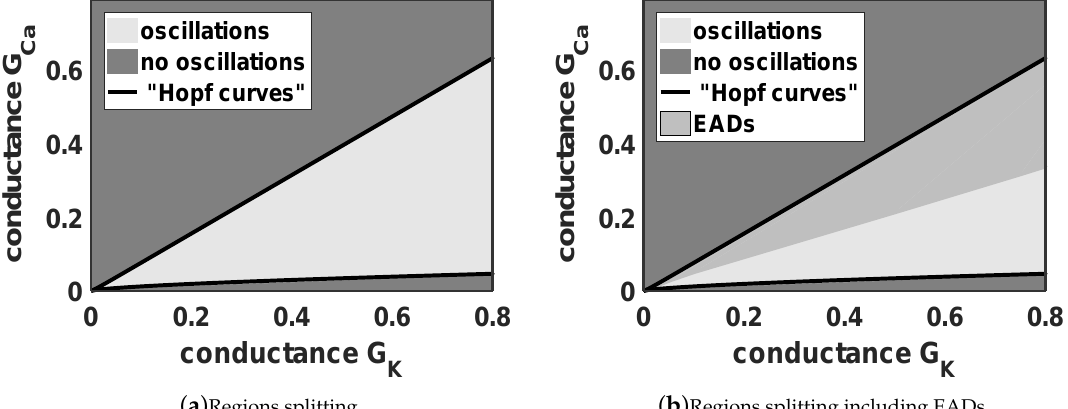
Figure 9. The two black lines represent the two “Hopf-curves”. Between these lines oscillations occur (light grey area), while outside this area (dark grey areas) no oscillations (in the sense we mentioned in Section 3) appear. Here, we have stable equilibria of system (1). Furthermore, the third area in Figure 9b represents the values of G K and G Ca , where EADs